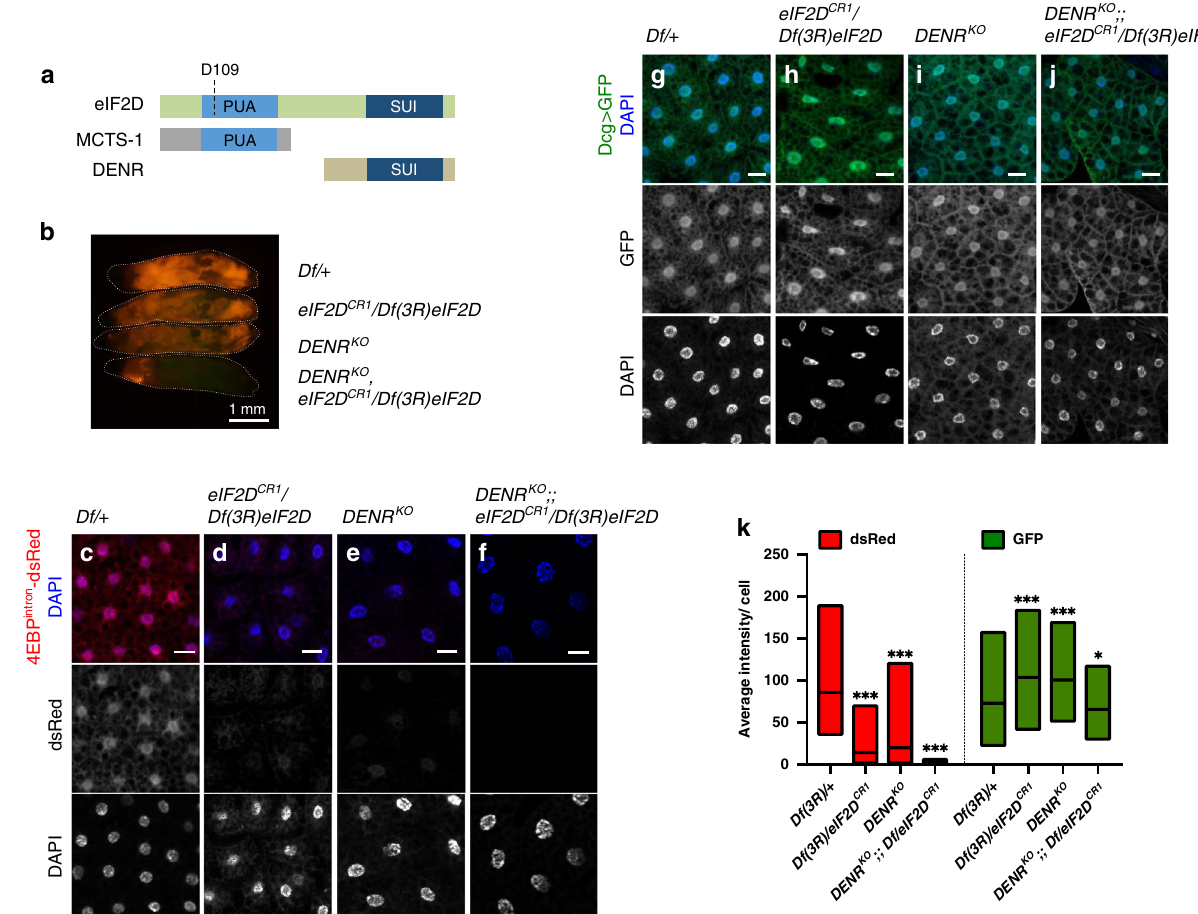
Fig. 3 eIF2D shares its function with DENR . a A schematic diagram showing the domain architecture of eIF2D, DENR, and MCTS-1. b Expression of 4E-BP intron -dsRed in eIF2D and DENR single mutants ( DENR KO ) compared with that of DENR; eIF2D double mutants. Individual larvae are indicated with dotted outlines and their genotypes are indicated on the right. c – f Fat body tissues dissected from larvae in b showing 4E-BP intron -dsRed (red) and DAPI (blue). g – j Fat body tissues from larvae of indicated genotypes expressing GFP (green) driven by the fat body speci fi c driver, Dcg-GAL4 , and counterstained with DAPI. k Quantitation of fl uorescent protein intensity from individual cells in c – j . Midline represents the mean value, with the top and bottom of the box representing the maximum and minimum values. Asterisks above boxes represent statistical signi fi cances between mutant and control values calculated with the a two-tailed t -test with *** p < 0.0001 and * p < 0.01. n = 384, 370, 426, 362, 103, 158, 145, and 138, respectively for each box from left to right. Data in b – j are representative images collected from three independent biological experiments with seven animals in each trial. Please see Source Data Files for the raw data used to generate graph in k